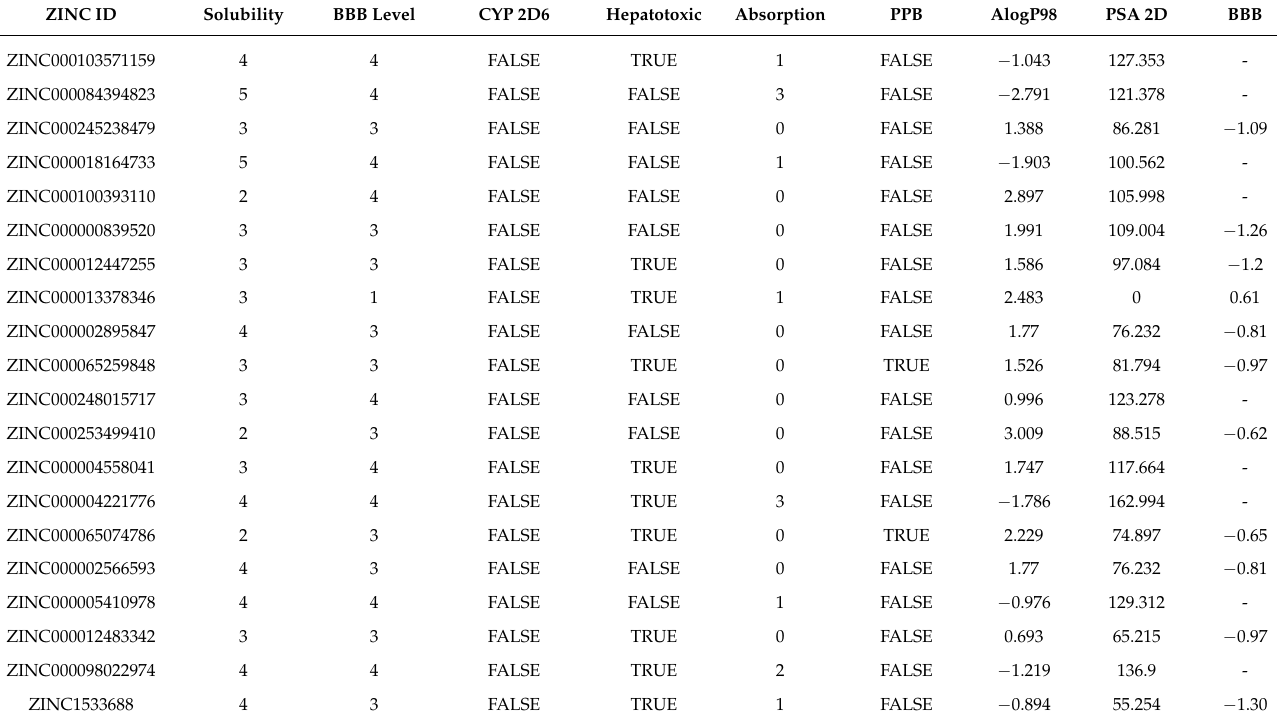
Table 4. In silico pharmacokinetic (ADMET) properties of the filtered